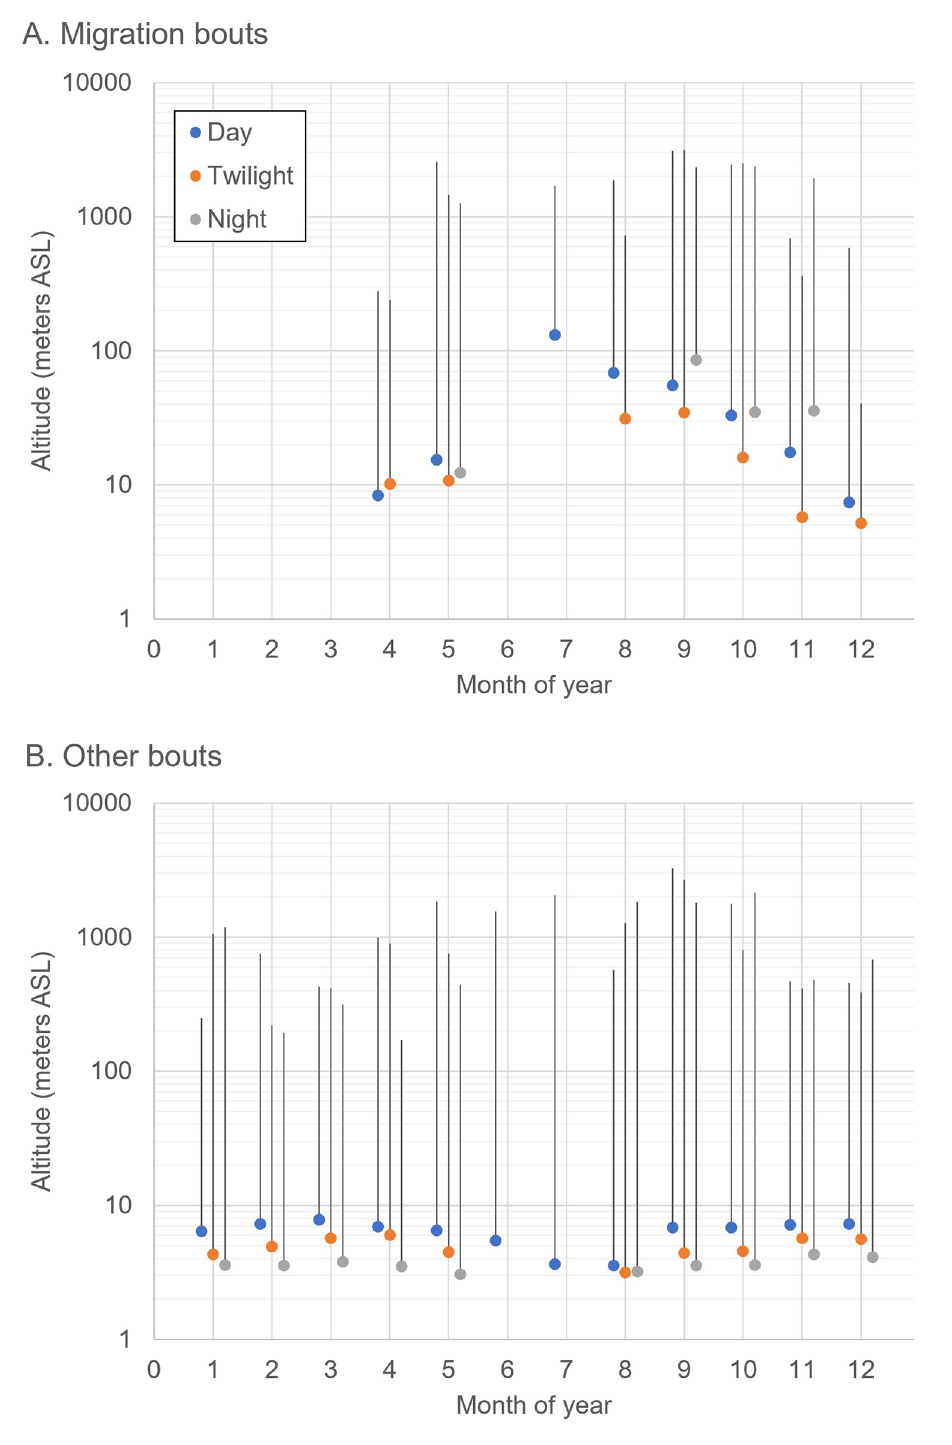
Fig 9. Median (dots) and maximum (lines) altitudes (in meters above sea level) of 15 Vega gulls during the day (blue), twilight (ochre) and night (grey): (A) Migration bouts, (B) Other bouts. Only medians estimated with 20 or more bouts are